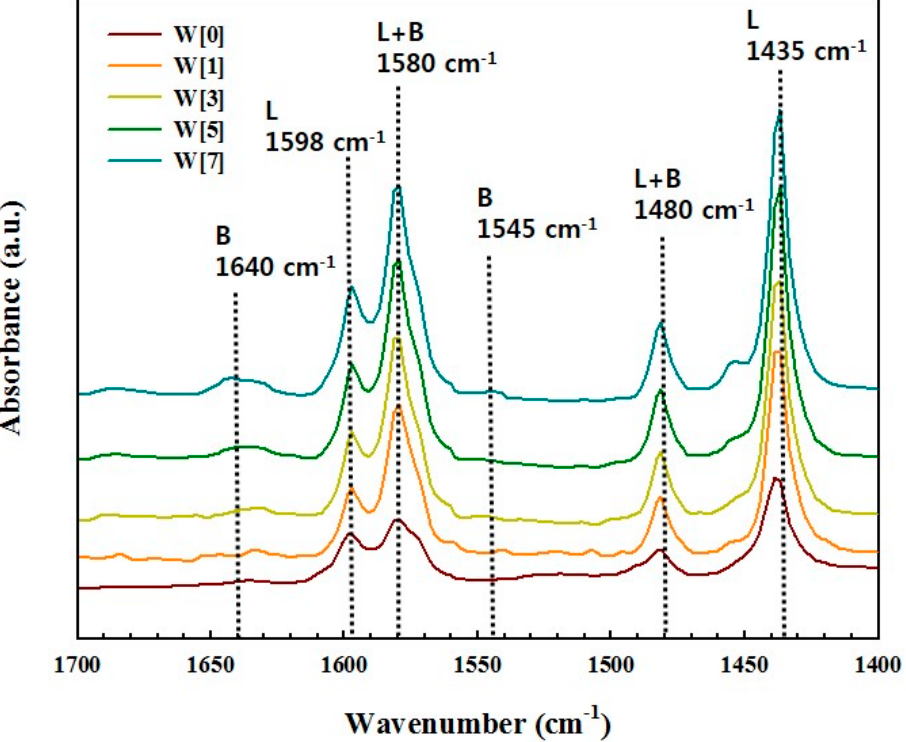
Figure 6. FT-IR spectra of Pt–W[x]/TiO 2 catalysts after pyridine adsorption and subsequent desorption at 200 °C . Table 5. Area and area ratio (B/L ratio) of Brønsted and Lewis acid sites on Pt–W[x]/TiO 2 catalysts.